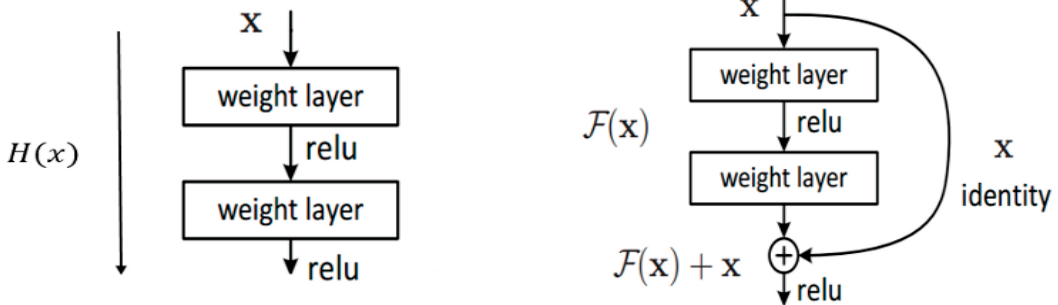
Figure 7. Normal CNN blocks and residual blocks.